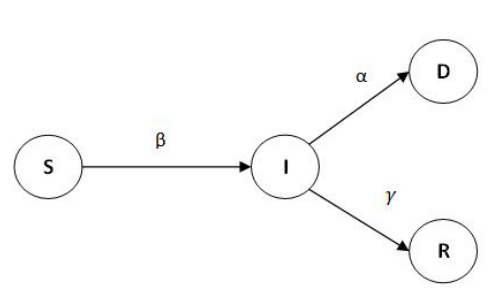
Figure 3. The state diagram for the SIRD